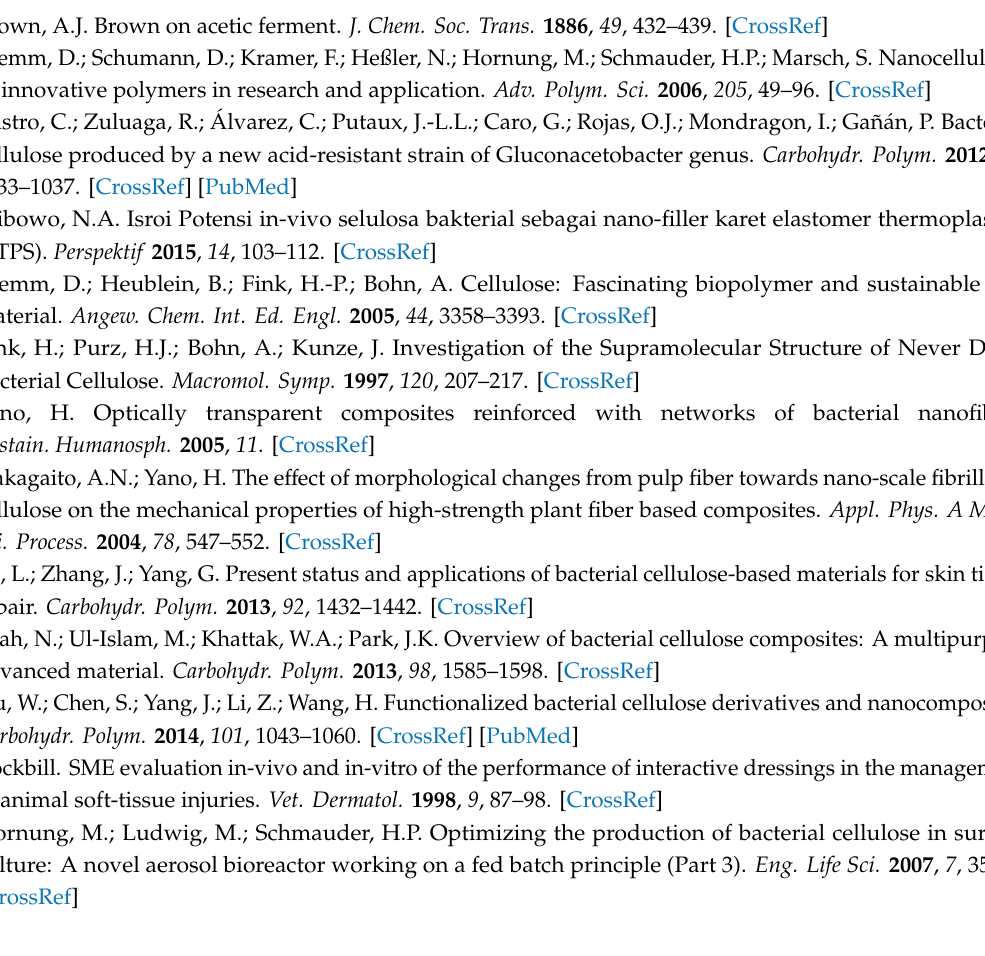
Supplementary Materials: Table S1. Height AFM images of the bacterial nanocellulose (BNC) when used to adsorb vitamins B1, B2, B3, and B12 and after treatment with di ff erent